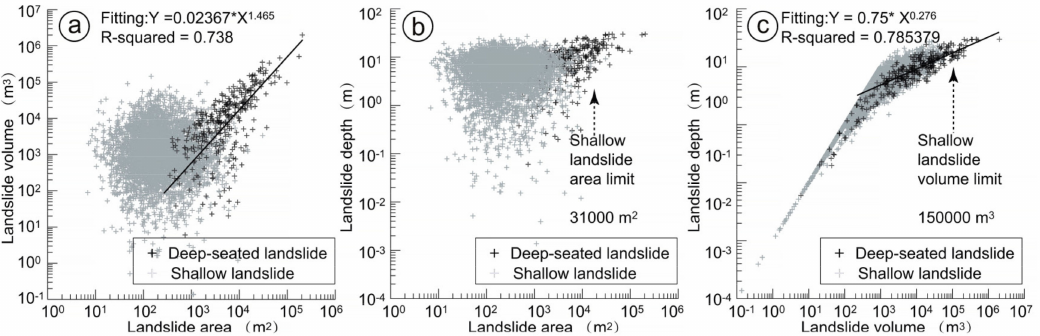
Figure 5. The relationship of landslide volume, landslide area and landslide depth. Landslide area and volume ( a ), landslide depth and area ( b ), and landslide depth and landslide volume ( c ) obtained from pre- and post-earthquake